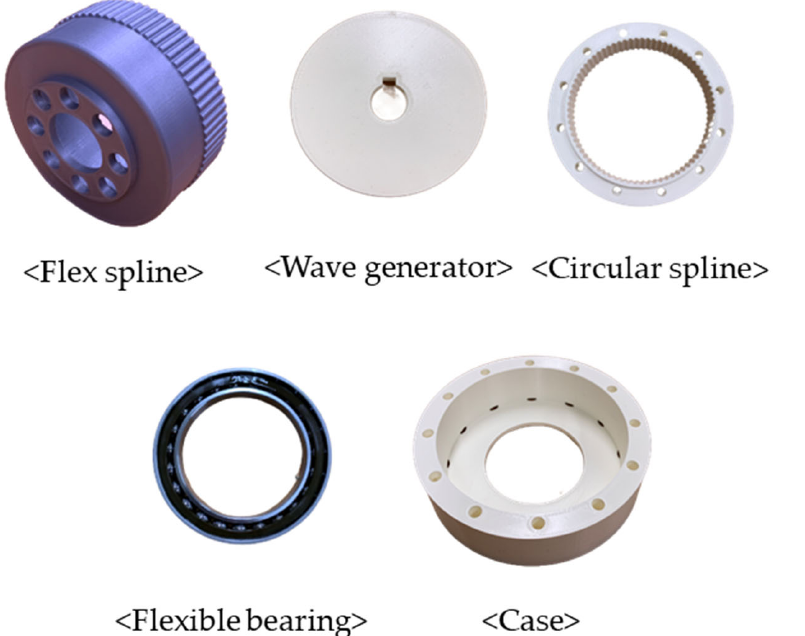
Figure 9. Mock-up model components. Figure 9. Mock ‐ up model components. Figure 9. Mock ‐ up model components.